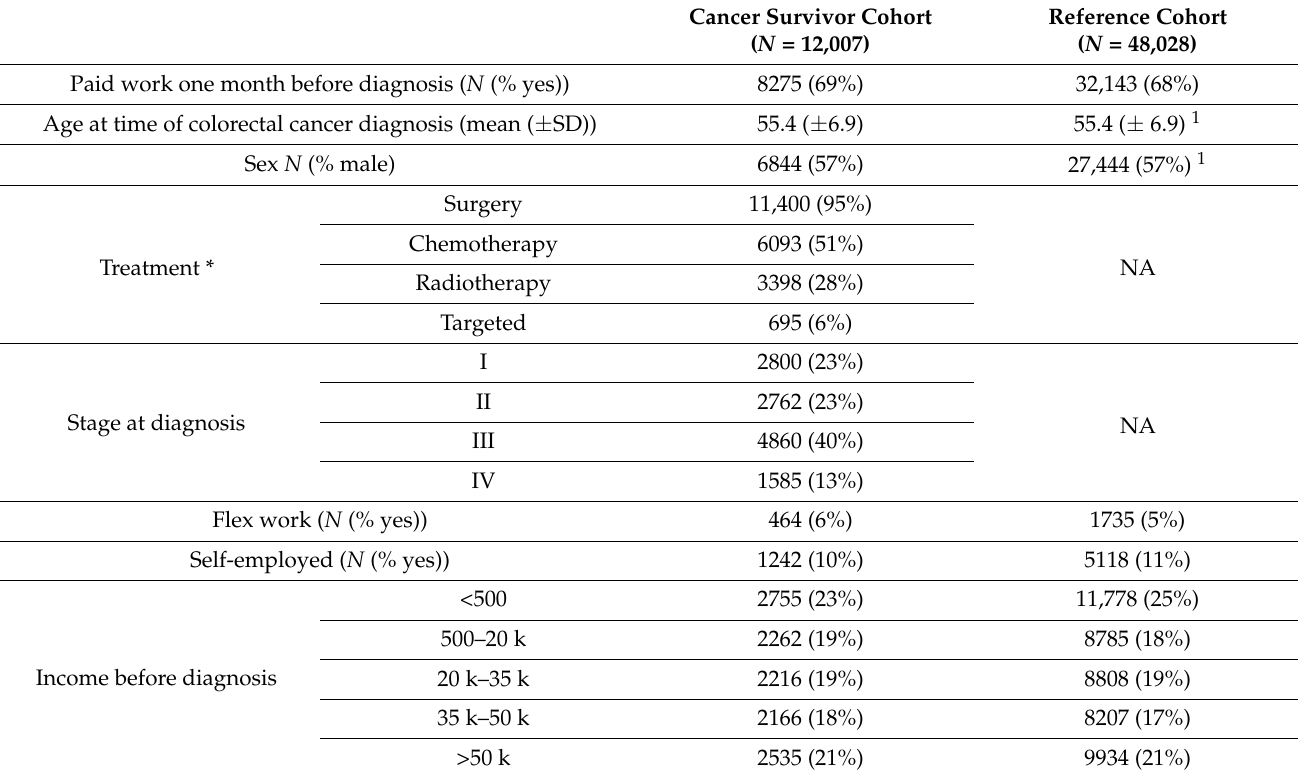
Table 1. Characteristics of the cancer survivor cohort and the reference cohort.